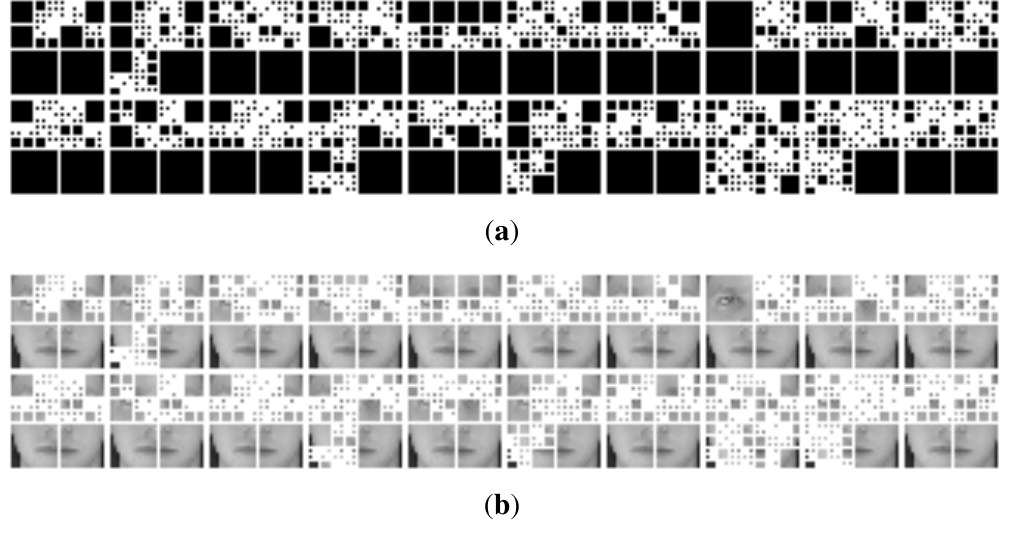
An example of 20 quad-trees: ( a ) quad-trees; ( b ) quad-tree partitions on a face